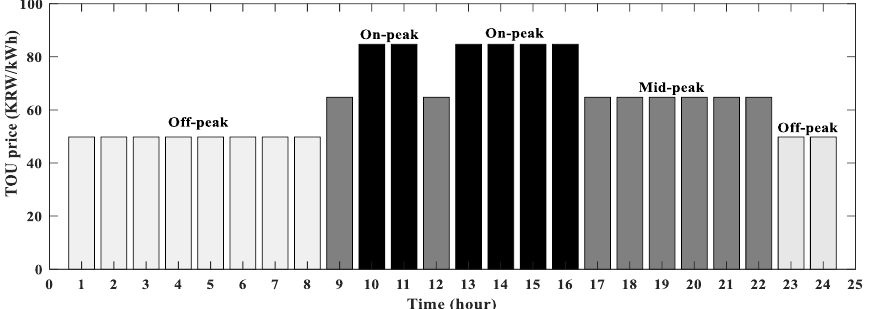
Figure 6. Time of use price used in the simulation.